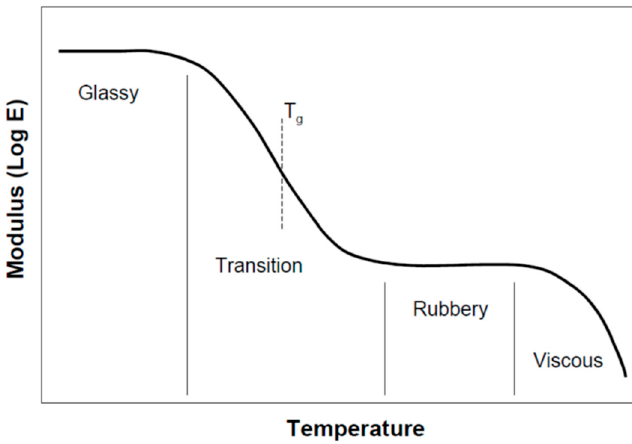
Figure 10. Variation of relaxation modulus with temperature for an amorphous polymer [88].